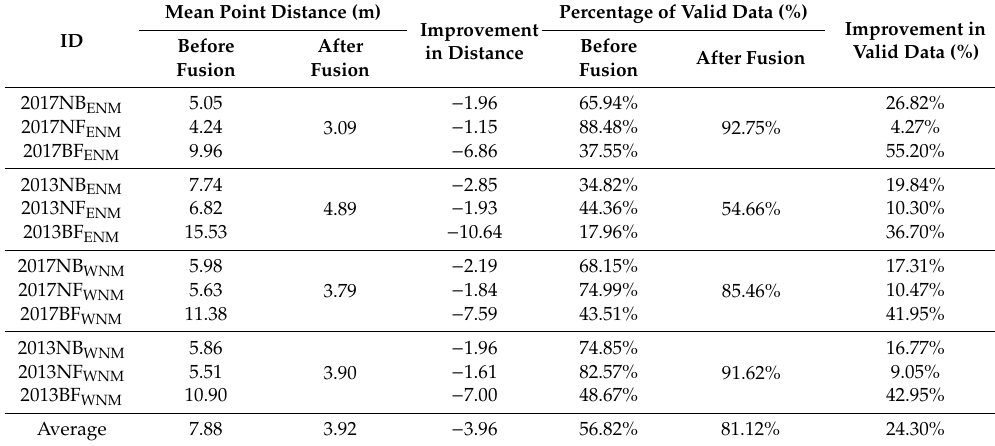
Table 4. Mean point distance and percentage of valid data before and after fusion of the point clouds from three view angle pairs generated with the ZY-3 TLA image data. Improvement in distance is given by the distance di ff erence between after and before fusing the point clouds, improvement in valid data is calculated by the percentage di ff erence between after and before fusing the DEM.